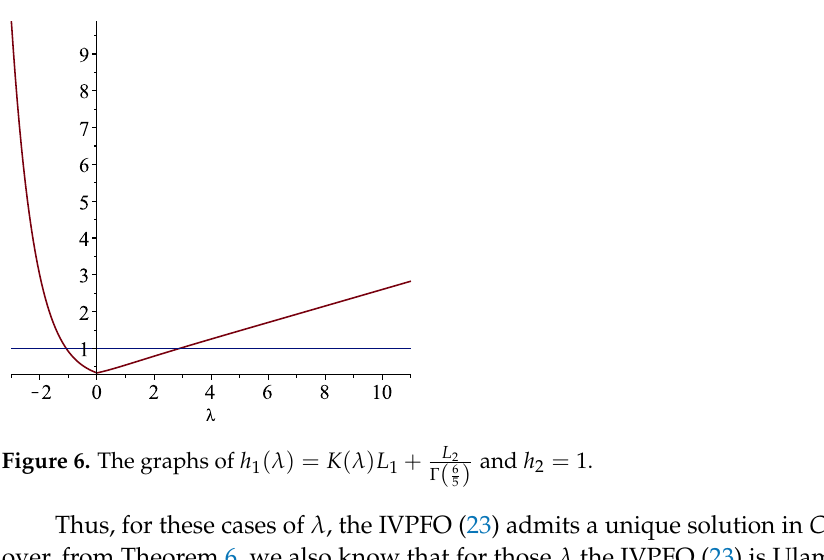
Figure 6. The graphs of h 1 ( λ ) = K ( λ ) L 1 + L 2